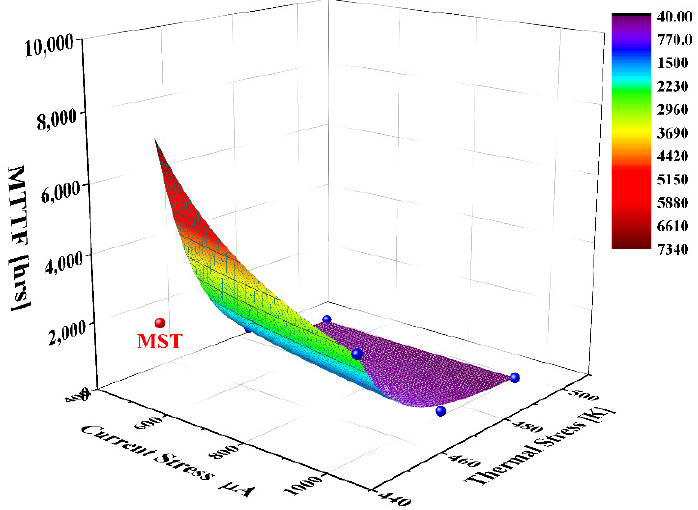
Figure 14. The results of the Eyring model for five distinct conditions with the projection of the